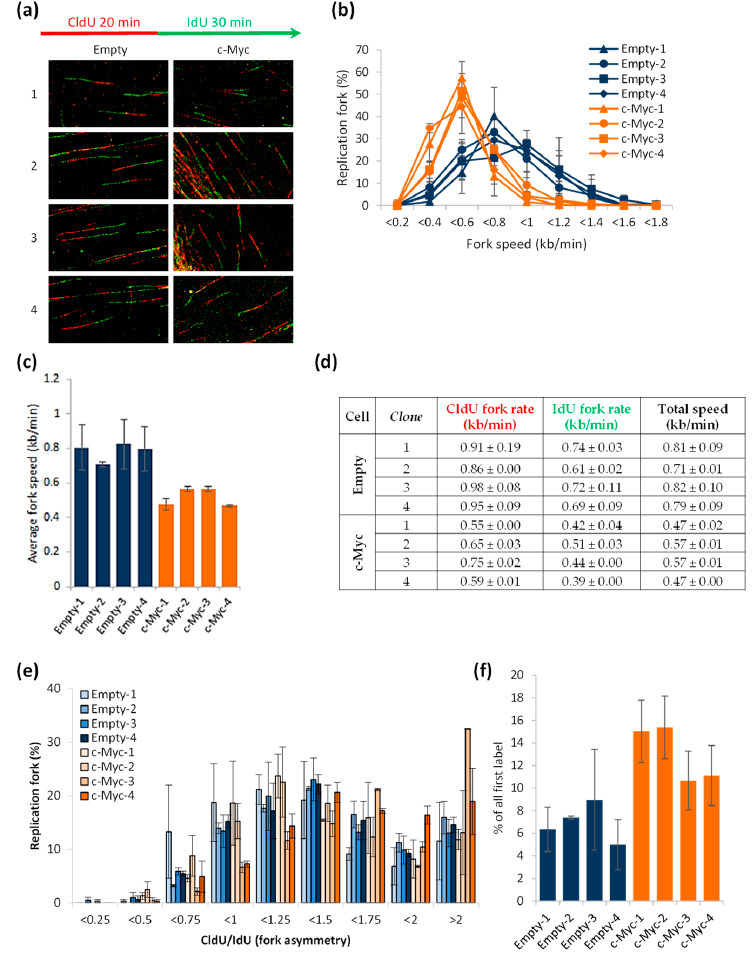
Figure 3. c-Myc overexpression induces replication stress. ( a – f ) Cells were seeded and left to grow for 48 h. After that, cells were labeled for 20 min with CldU, washed and labeled with IdU for 30 min. Finally, cells were harvested, and the DNA fibers were obtained. DNA containing CldU was stained in red and DNA containing IdU was stained in green. The length of individual, well-spread labeled fibers was measured and converted into kb/min. Quantitative data presented as means, n = 2 ± S.E.M. ( a ) Schematic illustration of CldU (red) and IdU (green) labeling during the assay and representative images of replicative fork tracks for control cells (HA1EB empty) and c-Myc overexpressing cells (HA1EB c-Myc). ( b ) Graph shows the distribution of fork progression speed (kb/min) of the first and second pulses. ( c ) Average of the replication fork extension rates during the first and the second pulses. ( d ) Quantification of the mean replication fork speed (kb/min) during the first (CldU, 20 min), the second (IdU, 30 min) and both pulses. ( e ) Distribution of CldU/IdU ratio of replication fork progression. The value equal to 1 means the extension speed was similar during both pulses (perfect symmetry). ( f ) First-label origins (green–red–green) are shown as percentage of all red (CldU) labeled tracks.